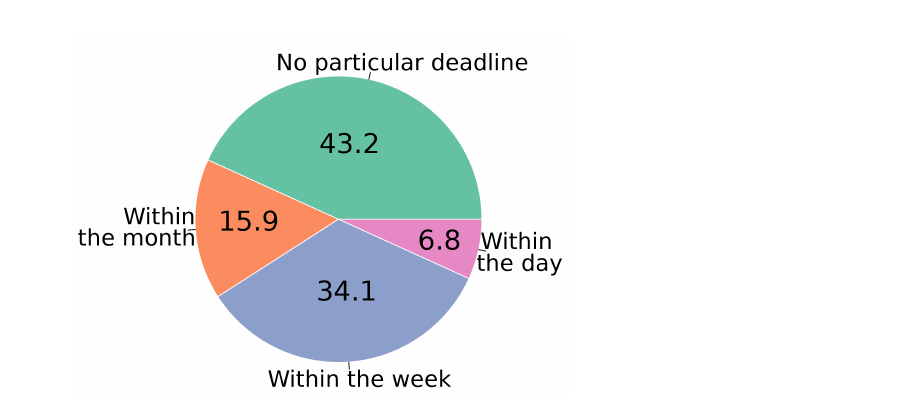
Figure 5. Responses of the question (in % of answers) on ’How soon did you have to respond or offer products to your users?’. Only one possible answer.